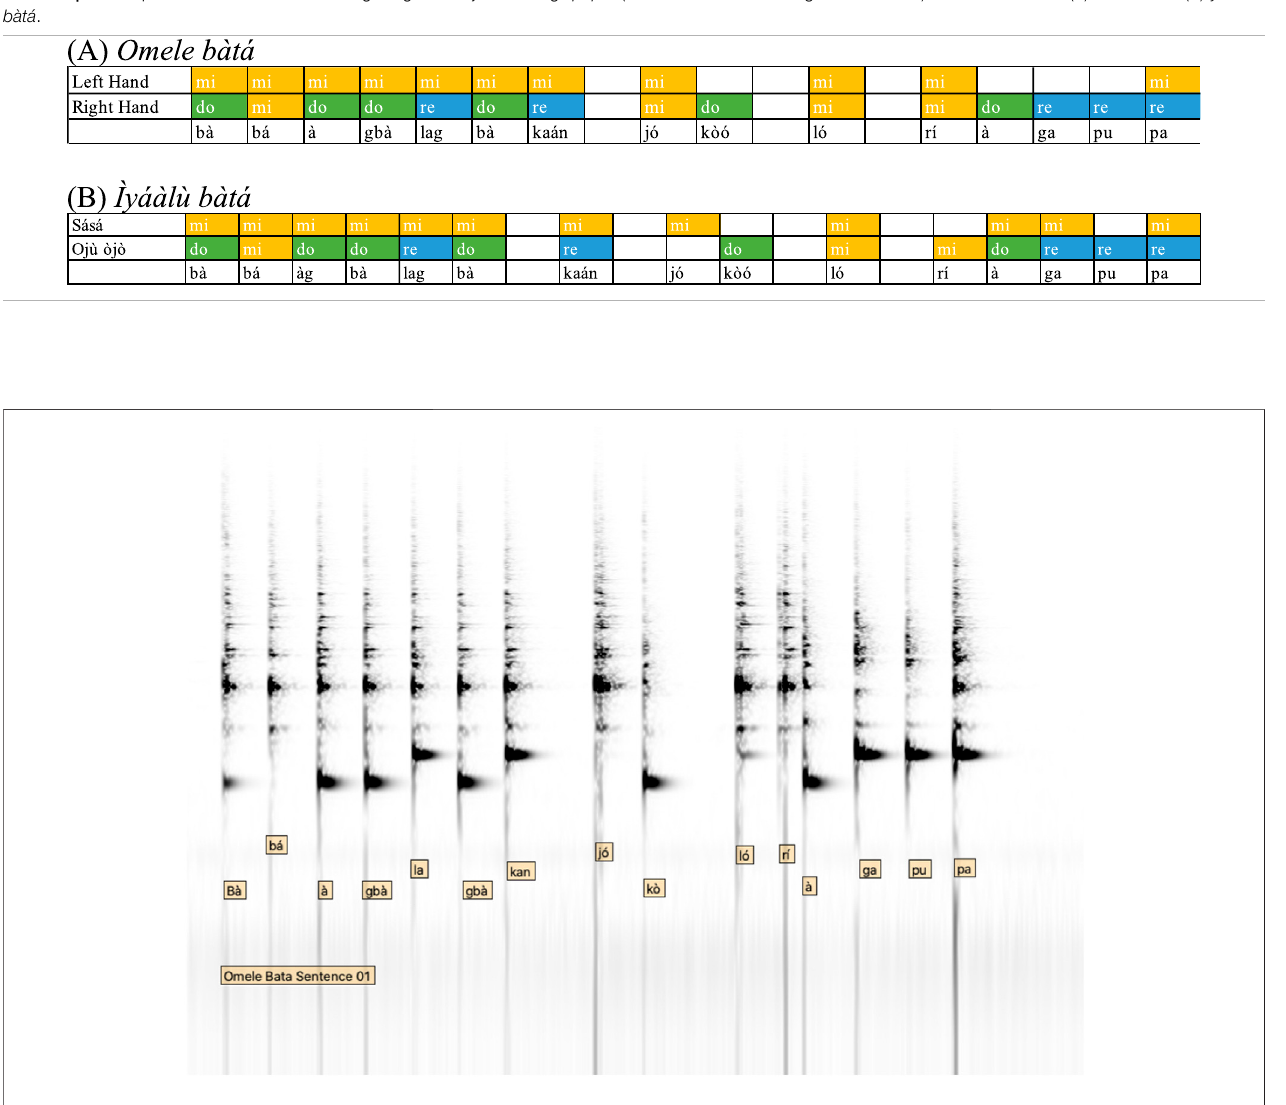
FIGURE 10 | Omele bàtá spectrogram for the sentence “ Bàbá àgbàlagbà kaán jókòó lórí àga pupa ” ( “ there is an old man sitting on a red chair ” ).